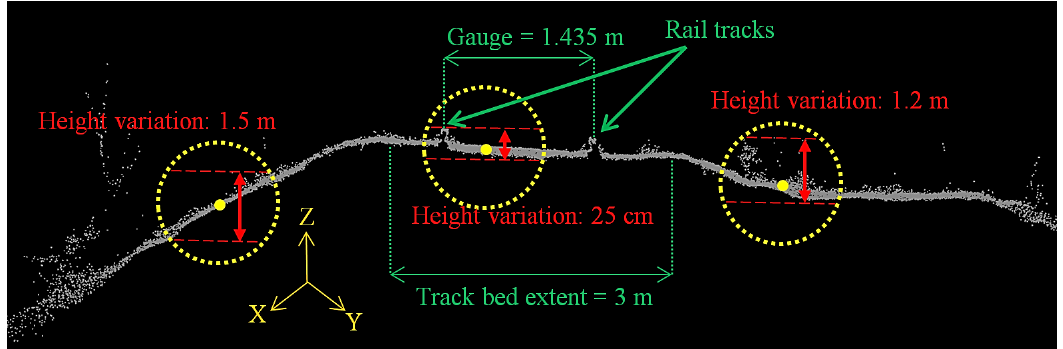
Figure 4. Height variation in various parts of the railroad corridor. Yellow points and yellow dashed circles represent sample query points and their corresponding 3D spherical neighbourhood and double arrows depict the height variation within each local neighbourhood.